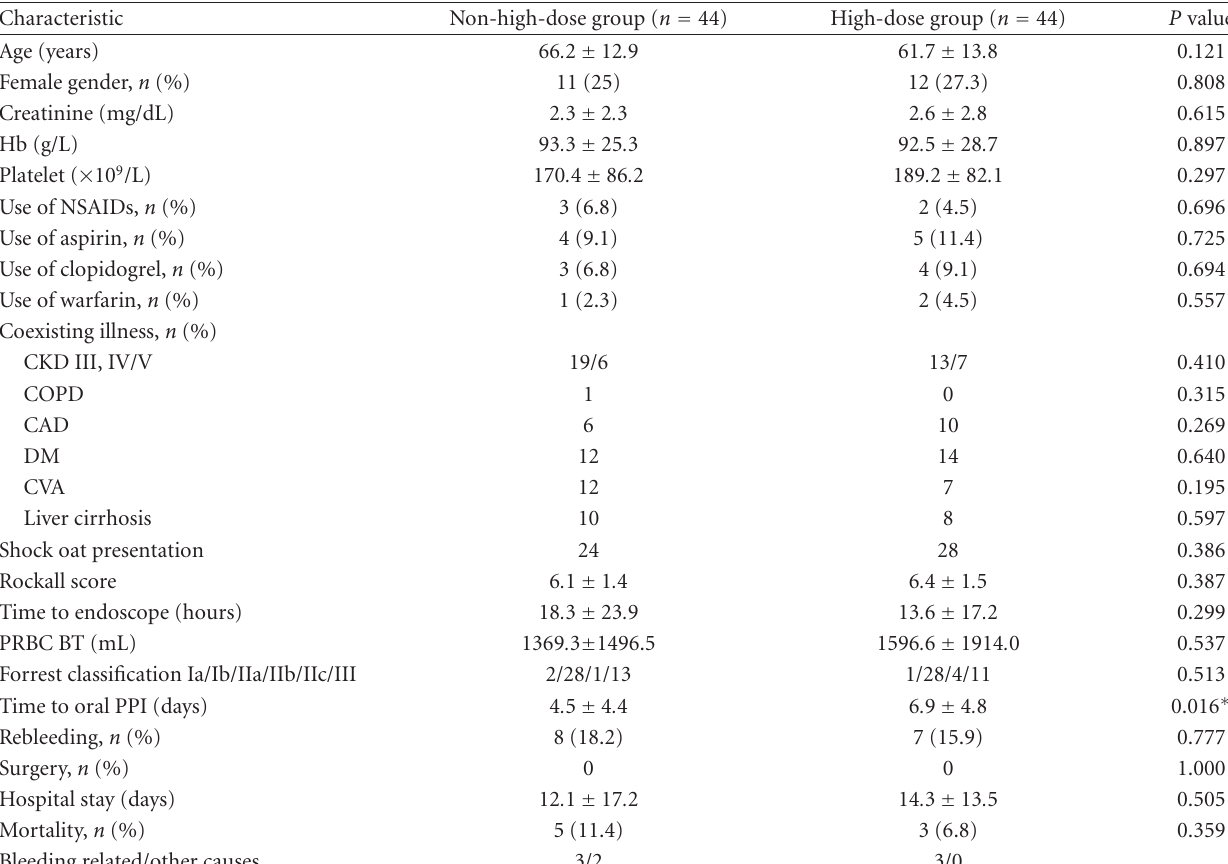
Table 4: Comparison between the non-high-dose and high-dose PPI after case-controlled